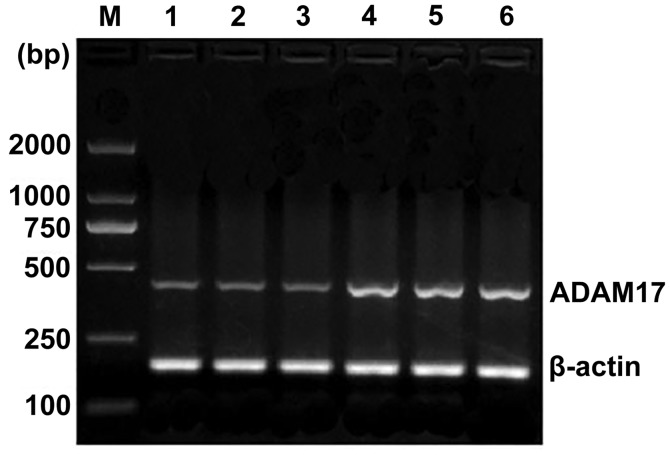
ADAM17 mRNA reverse transcription polymerase chain reaction amplification results. Lanes: M, DNA marker; 1–3, esophageal squamous cell carcinoma without lymph node metastasis; 4–6, esophageal squamous cell carcinoma with lymph node metastasis. ADAM17, a disintegrin and metalloproteinase 17.